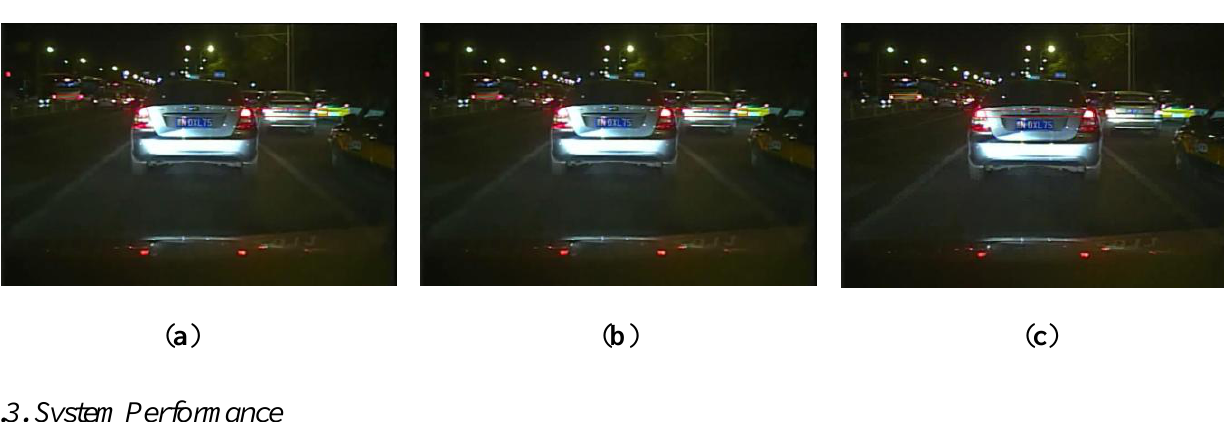
Figure 14. Comparison of vehicle detection results (case 5): ( a ) Result using the global rule-based algorithm; ( b ) Result using Kalman tracking-based global algorithm; ( c ) Result using the proposed algorithm.